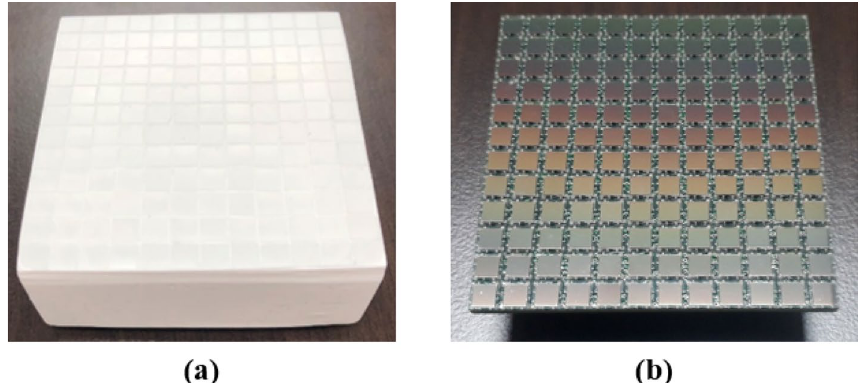
Figure 12. Stilbene scintillator array (12 × 12 pixels of 4 × 4 × 20 mm 3 each) ( a ), and SiPM array with the same number and area of pixels ( b ).